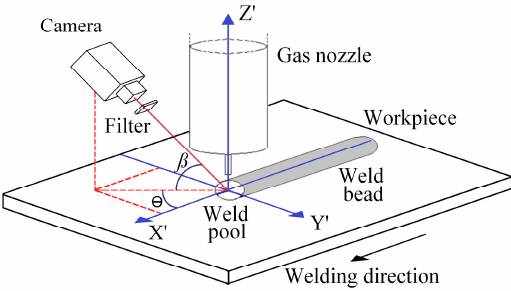
Figure 2. Image acquisition setup including the world coordinate system.